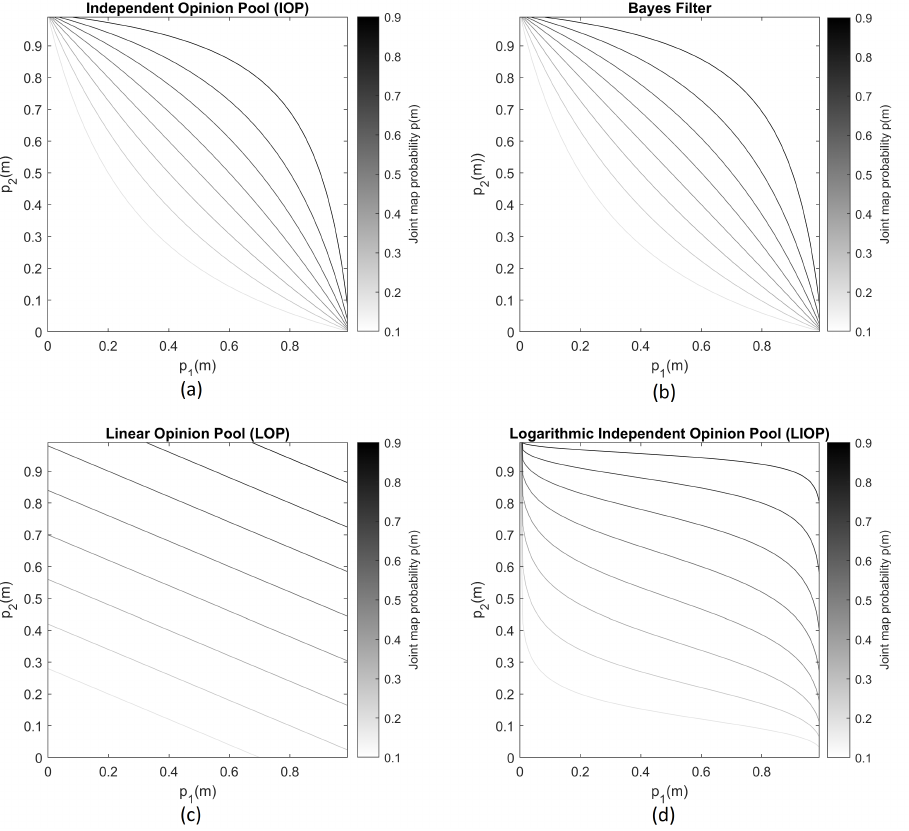
Figure 4. Contour map of p(m) w.r.t. different p 1 ( m ) and p 2 ( m ) ( a ): Independent Opinion Pool ( b ): Bayes filter ( c ): Linear Opinion Pool ( w 1 = 0.4, w 2 = 1) ( d ): Geometric Opinion Pool ( w 1 = 0.25, w 2 =